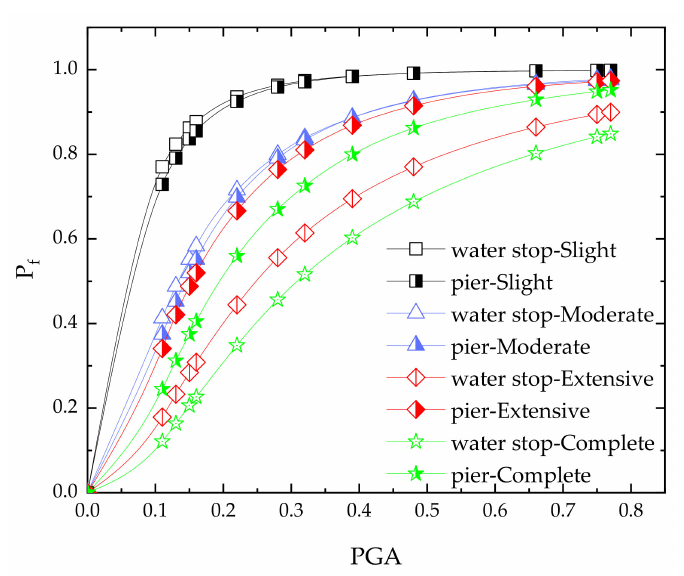
Figure 11. Comparison of fragility curves of the pier and the water